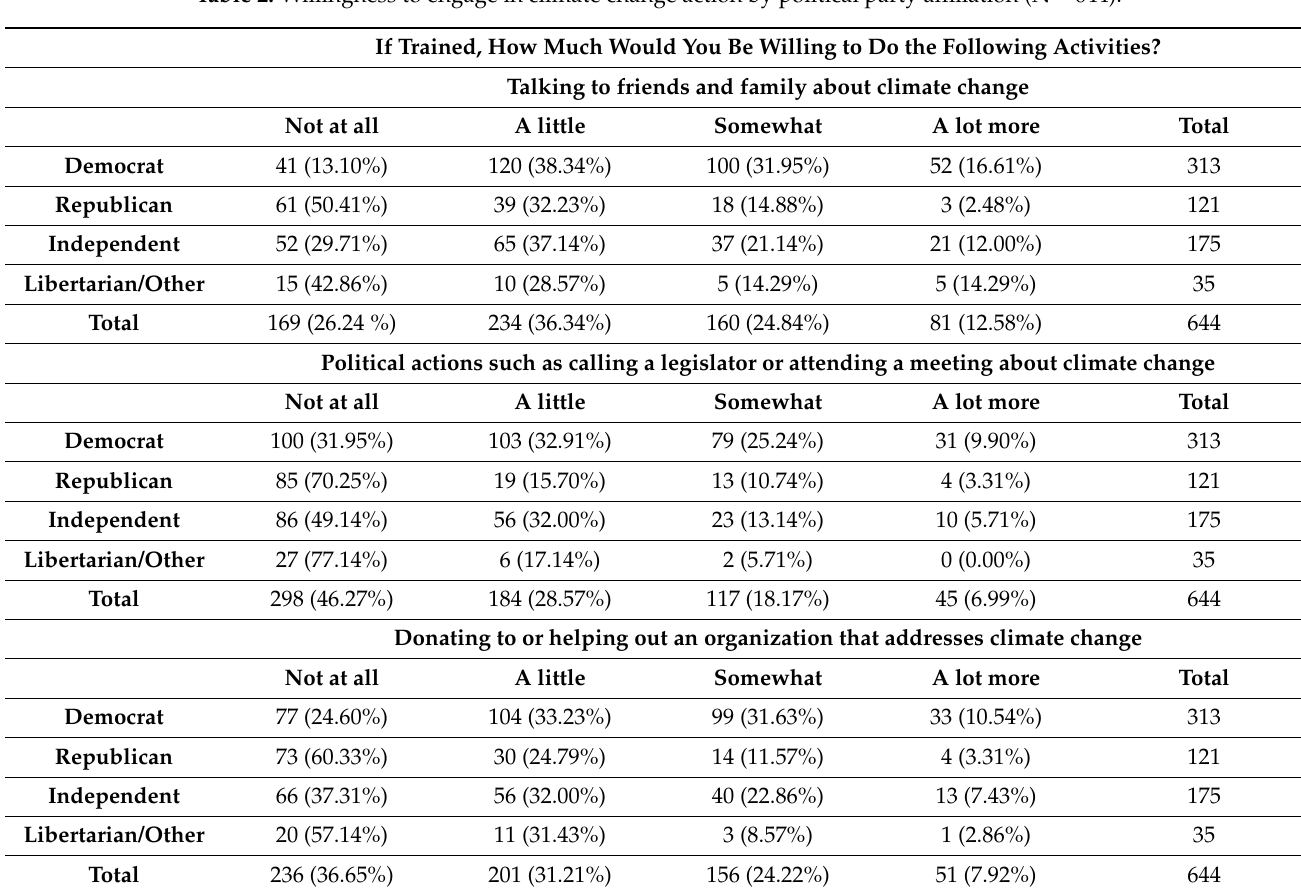
Table 2. Willingness to engage in climate change action by political party affiliation (N =